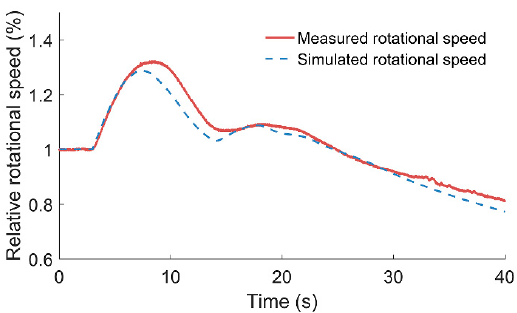
Figure 8. GVCS and ball valve closing schemes (BVCS) in the field test.